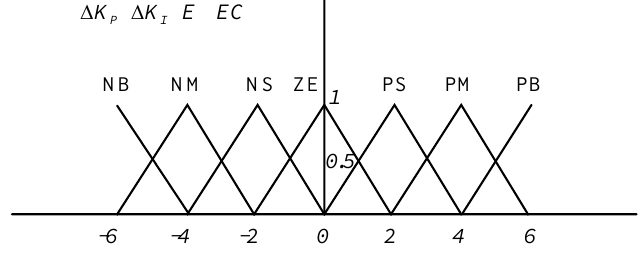
Figure 9. Triangle membership function diagram.